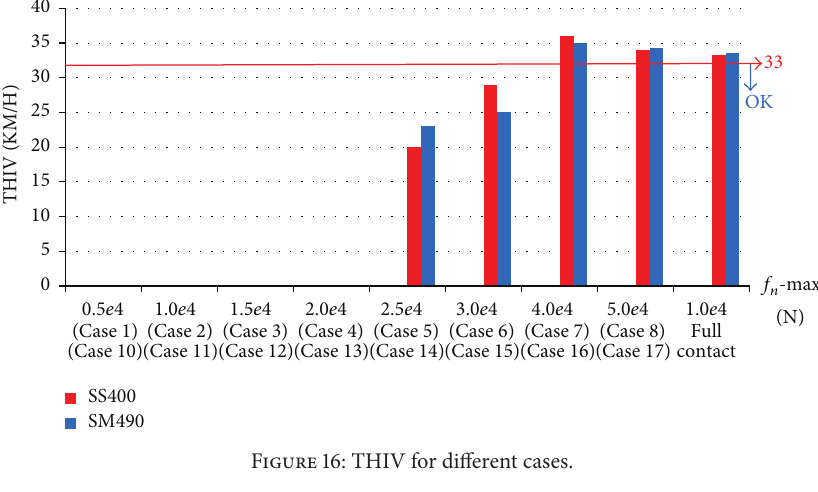
Figure 16: THIV for different